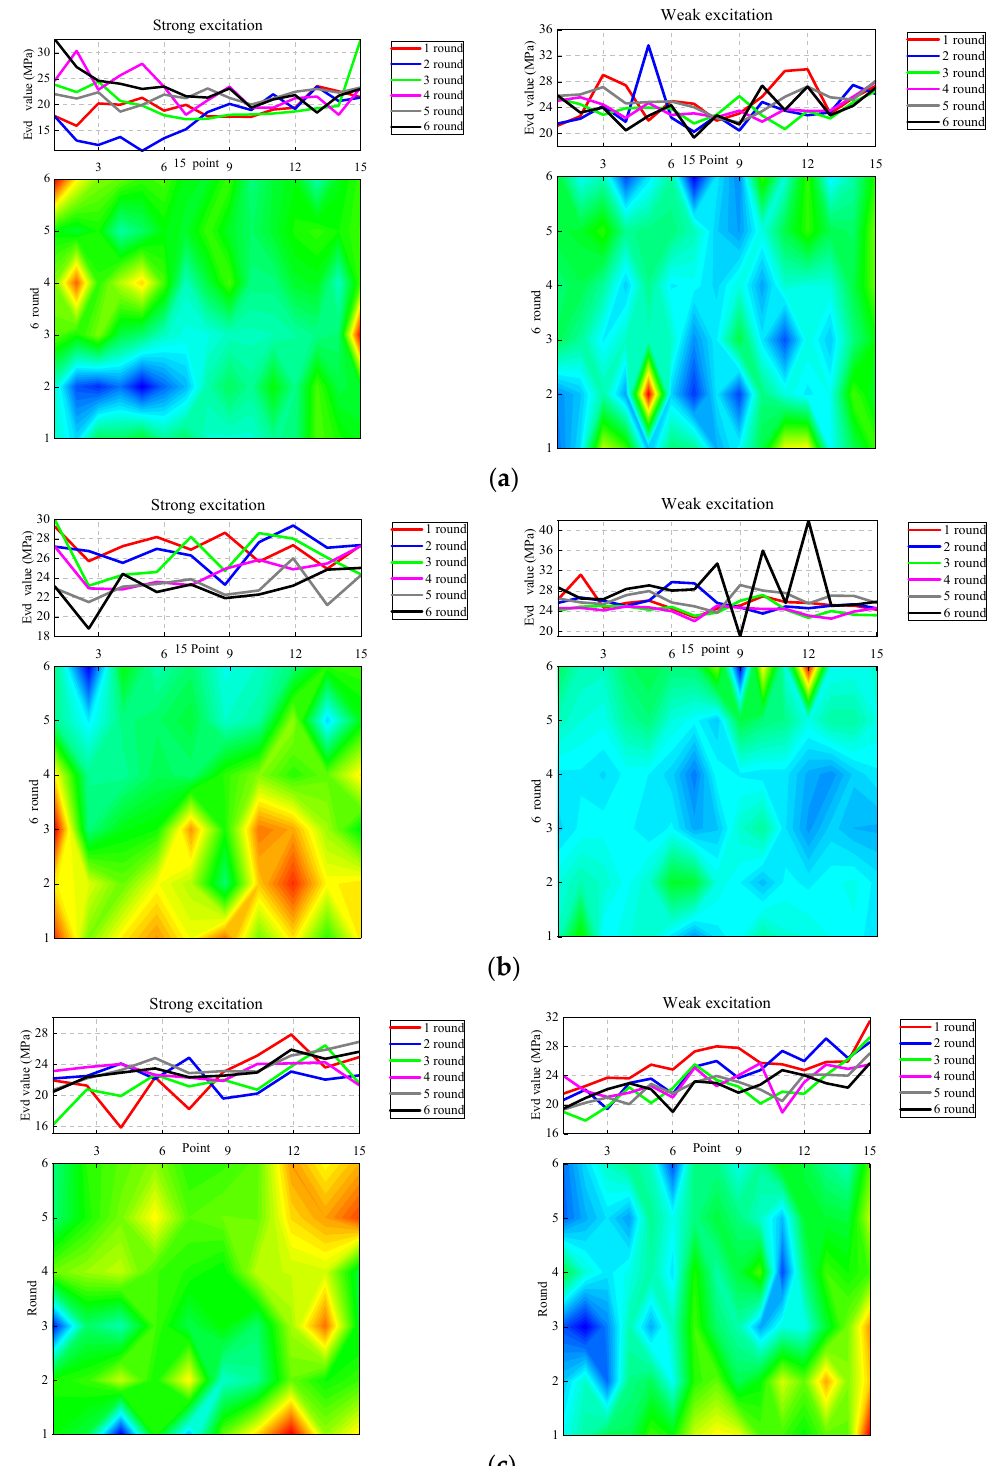
Figure 13. E vd contour map. ( a ) The speed of the vibratory roller is 1.5 km/h. ( b ) The speed of the vibrated roller is 3 km/h. ( c ) The speed of the vibrated roller is 4.5 km/h.